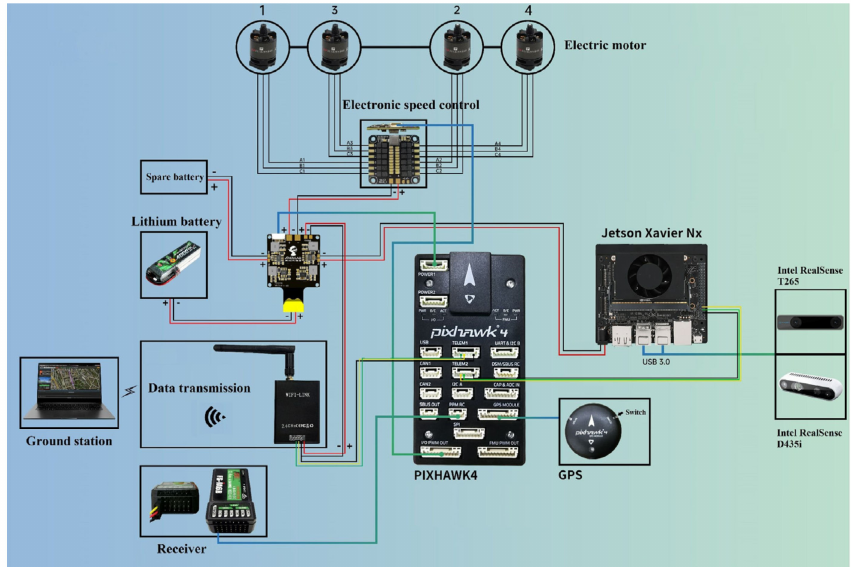
Figure 6. The connecting scheme of aerial robot.